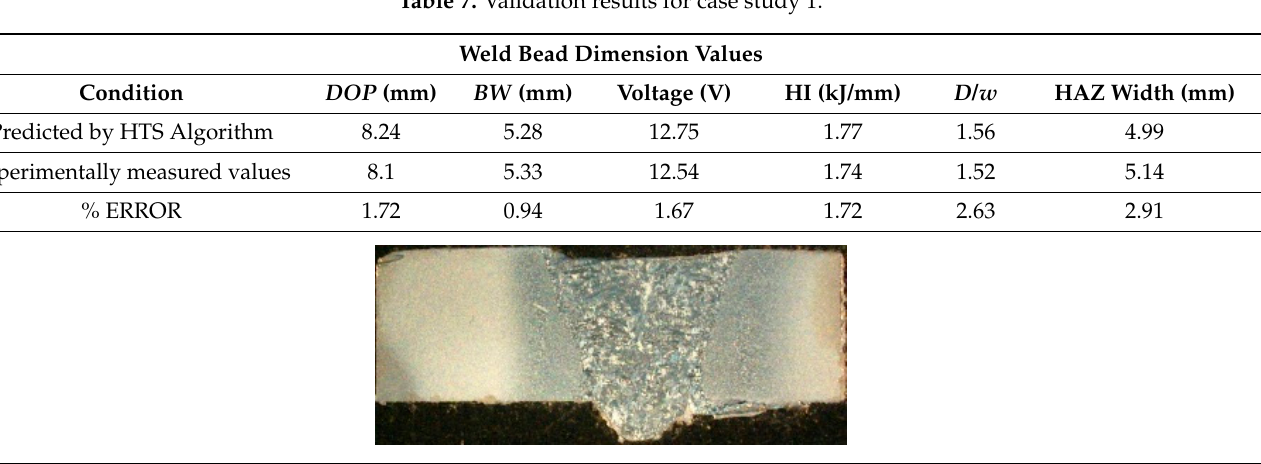
Table 7. Validation results for case study 1.